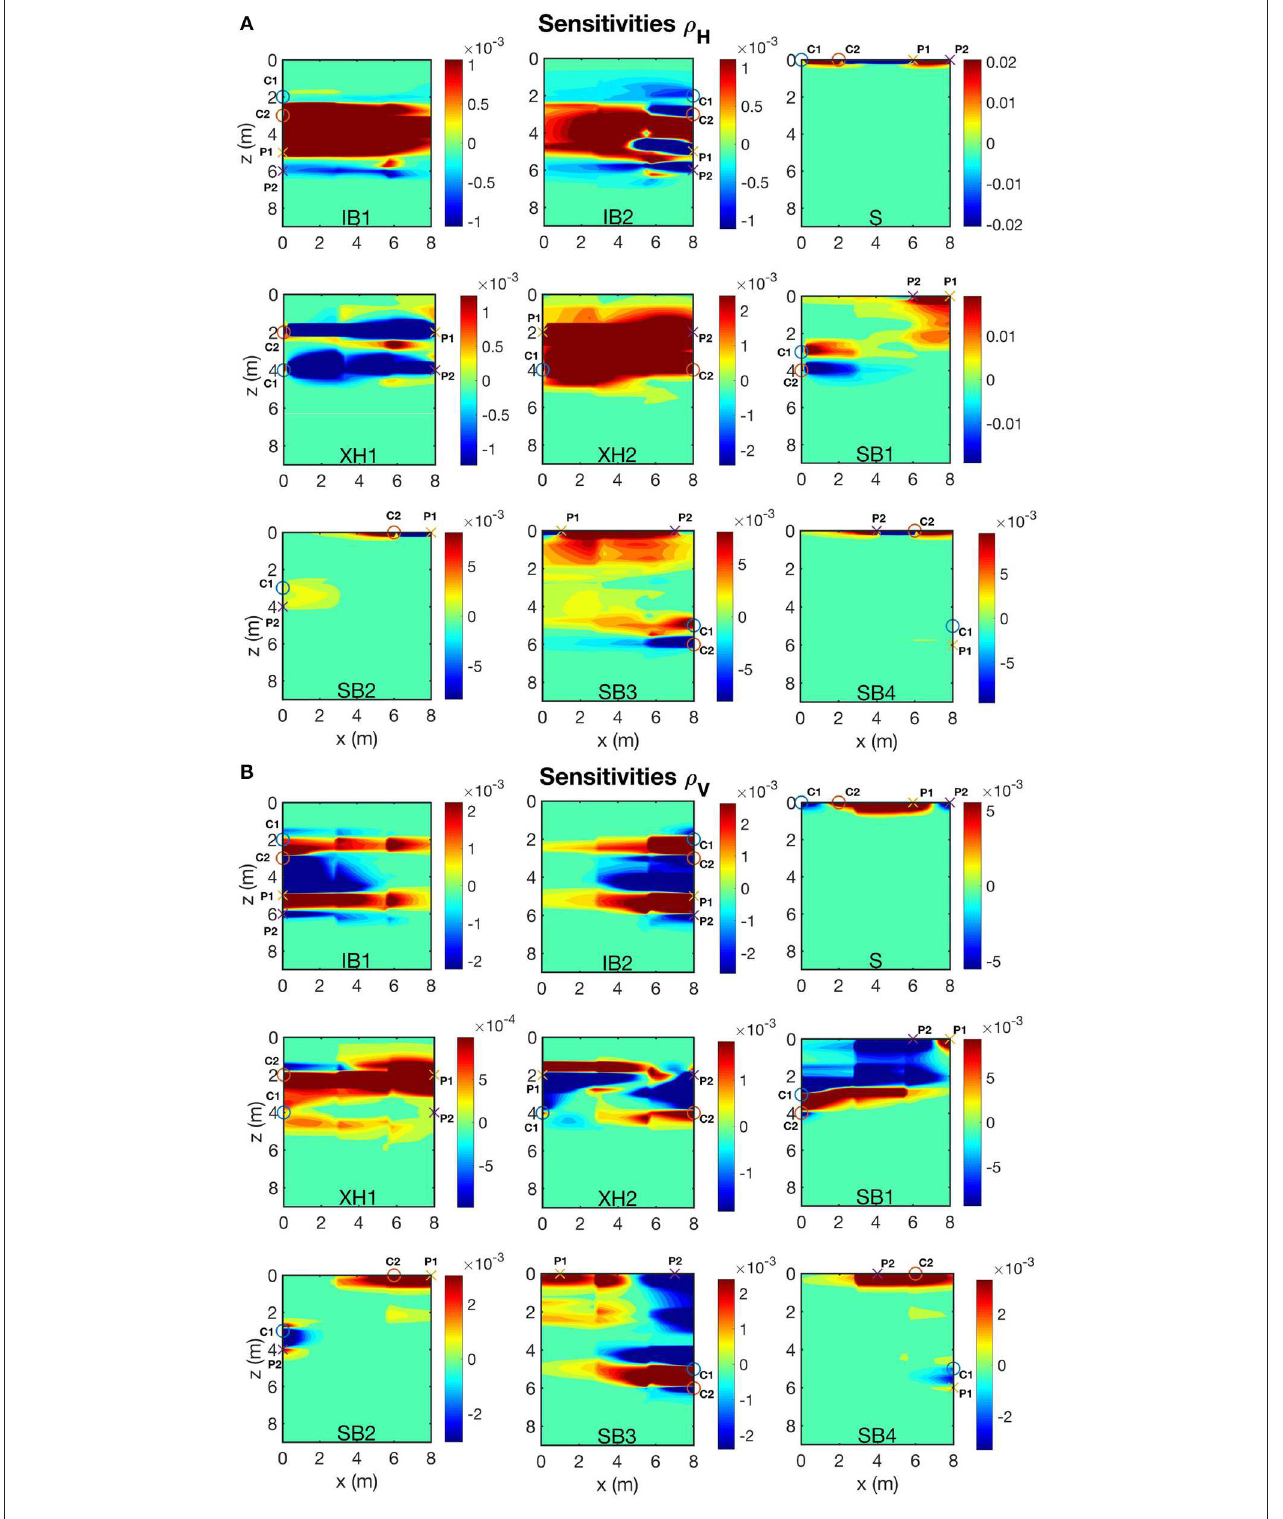
FIGURE 5 | The sensitivity pattern is obtained from the Jacobian matrix (matrix of the potential derivatives according to the resistivity values of the model) computation of the electrode quadrupoles on the synthetic model from Figure 3 . (A) Sensitivity pattern relative to ρ H and (B) Sensitivity pattern relative to ρ V . Same subprotocols as Figure 4 . represent the current electrodes C1 and C2 and represent the potential electrodes P1 and P2. ◦ ×